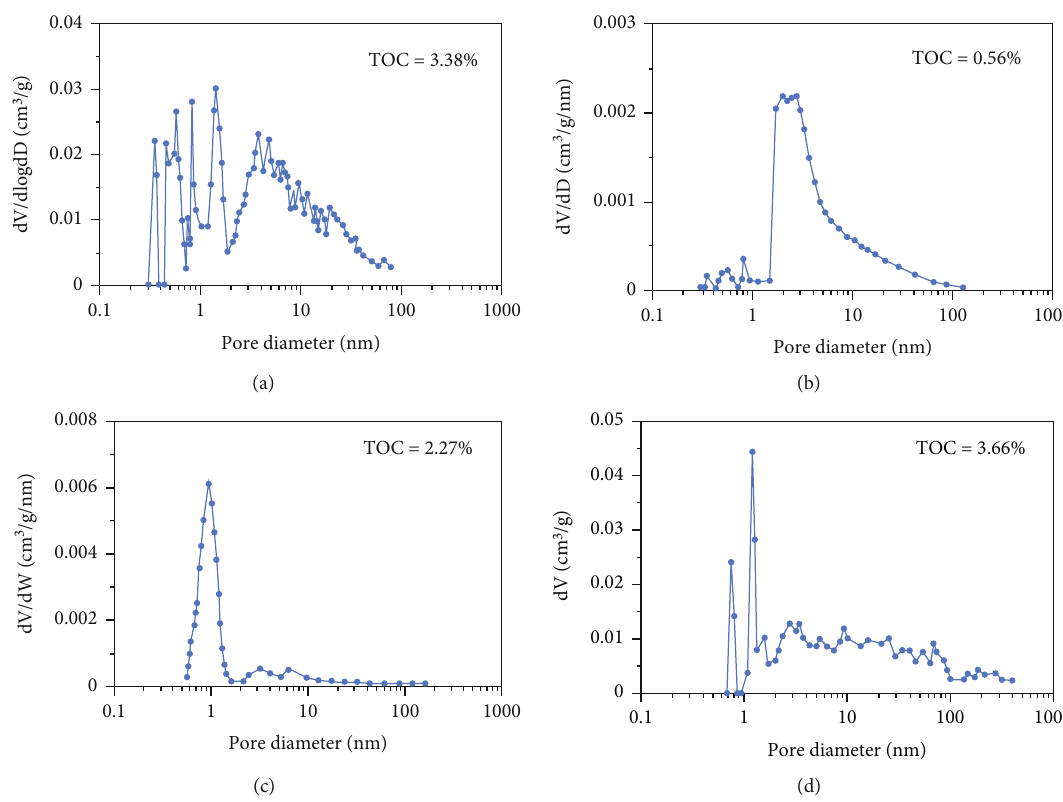
Figure 5: Pore size distribution of the Lower Paleozoic shales in southern China. (a) The Lower Silurian shale samples in southern Sichuan, (b) the Lower Cambrian shale samples in southern Sichuan, (c) the Lower Cambrian shale samples in northeastern Chongqing, and (d) the Lower Cambrian shale samples in northern Guizhou (modi fi ed from Wu et al. [16]; Wang et al. [121]; Yang et al. [122]; Zhu et al. [123]). 0.8